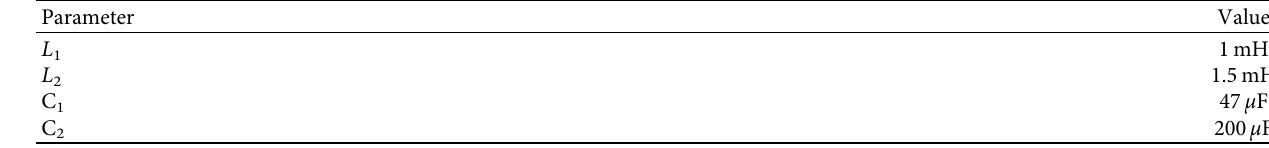
Table 4: Converter parameters.